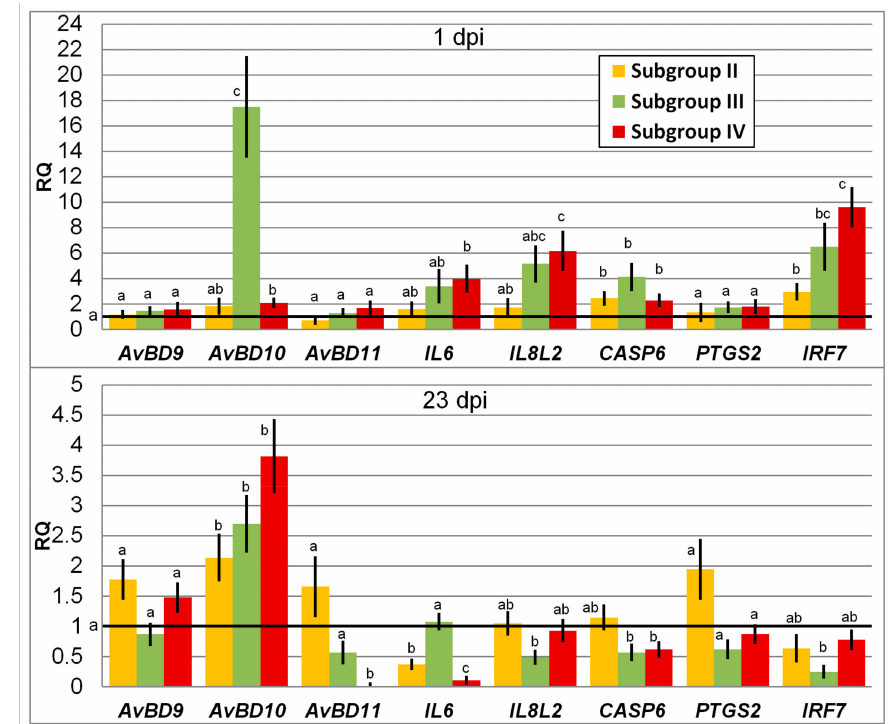
Figure 1. Relative quantification (RQ) of expression of the chicken genes involved in the immune response due to Salmonella enterica serovar Enteritidis (SE) infection and phytobiotic administration. Line shows the basal expression level in Subgroup I (negative control) taken as 1. a–c Mean RQ values for the control and experiment subgroups within a gene with no common letters di ff ered significantly ( p < 0.05), with a corresponding to Subgroup